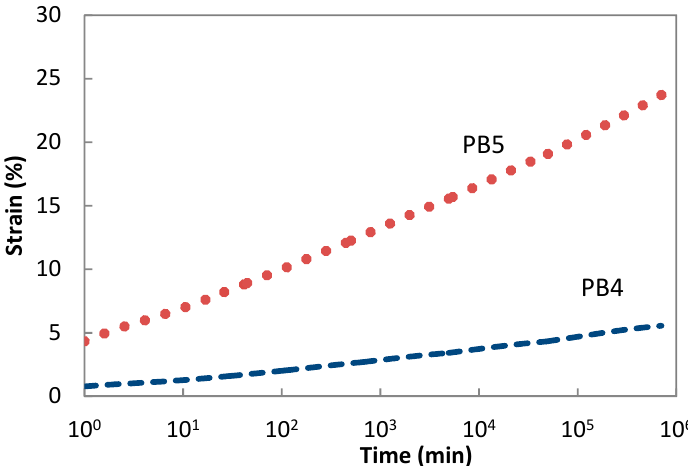
Figure 6. Master creep curves of PB4 and PB5 at the reference temperature 30 °C.